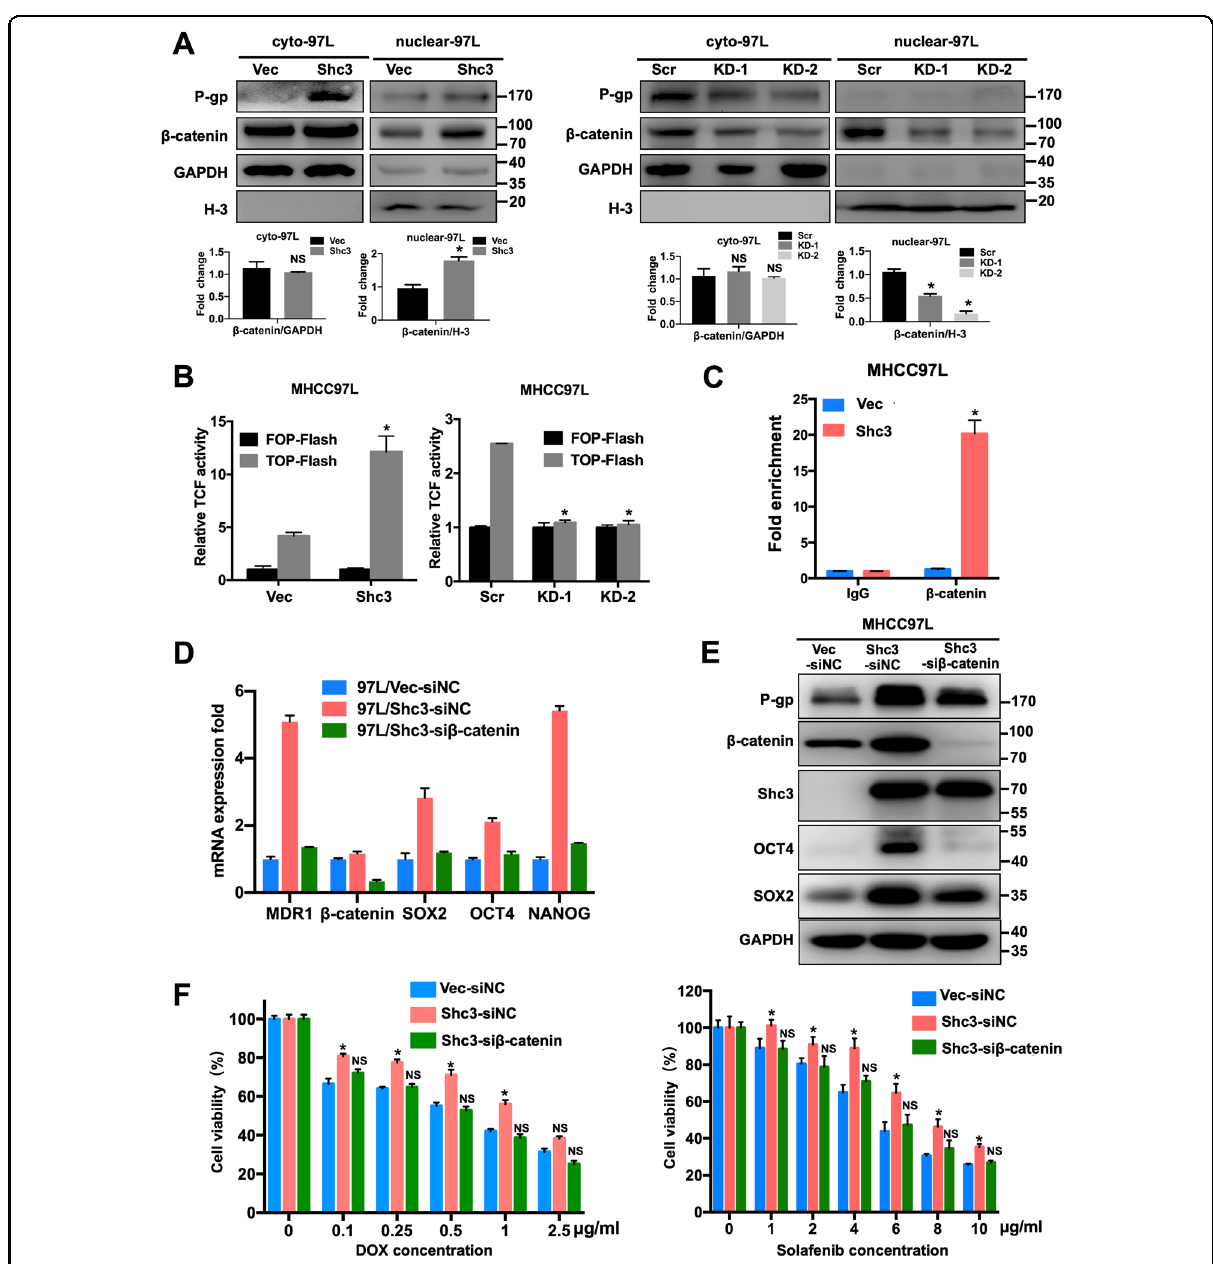
Fig. 6 Shc3 induces MDR1 expression in HCC cells via β -catenin signaling pathway. A Up, the relative nuclear and cytoplasmic expression of P-gp, β -catenin and Shc3 was compared between MHCC97L/Shc3 or MHCC97L/KD cells and its control cells using western blots. Bottom, the histogram shows the comparison of the relative intensity of β -catenin and GAPDH, β -catenin and H-3. B Changes in β -catenin/TCF reporter activity in overexpression or knockdown Shc3 MHCC97L cell lines, Data are shown as mean ± SD; n = 3; * P < 0.05. C ChIP-PCR experiment of β -catenin binding to the promoter of MDR1 in MHCC97L/Vector and MHCC97L/Shc3 cells, Data are shown as mean ± SD; n = 3; * P < 0.05. D , E β -catenin siRNAs were transfected into Shc3-overexpressing MHCC97L cells. qRT-PCR was used to examine the relative mRNA expression levels of MDR1, β -catenin, SOX2, OCT4 and NANOG; western blot analysis was used to examine the relative expression levels of P-gp, β -catenin, Shc3, OCT4 and SOX2. F Shc3- overexpressing MHCC97L cells transfected with β -catenin siRNAs were treated with doxorubicin (left) and sorafenib (right) for 48 h. Data are shown as mean ± SD; n = 5; * P < 0.05. Cell viability was calculated using the CCK8 assay and compared with 100% viability non-treated cells. Error bars represent the mean ± SD (* P < 0.05 vs control, by one-way ANOVA or Student ’ s t -test).